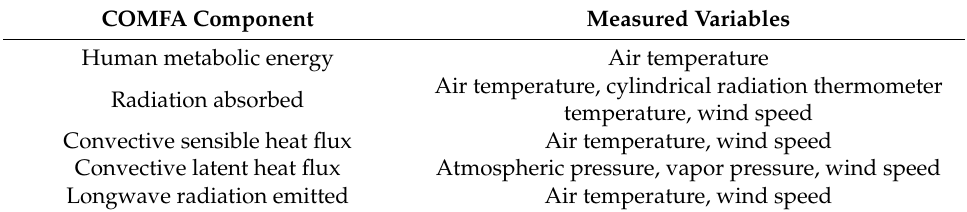
Table 1. Comfort Formula (COMFA) components and the measured variables needed to calculate each